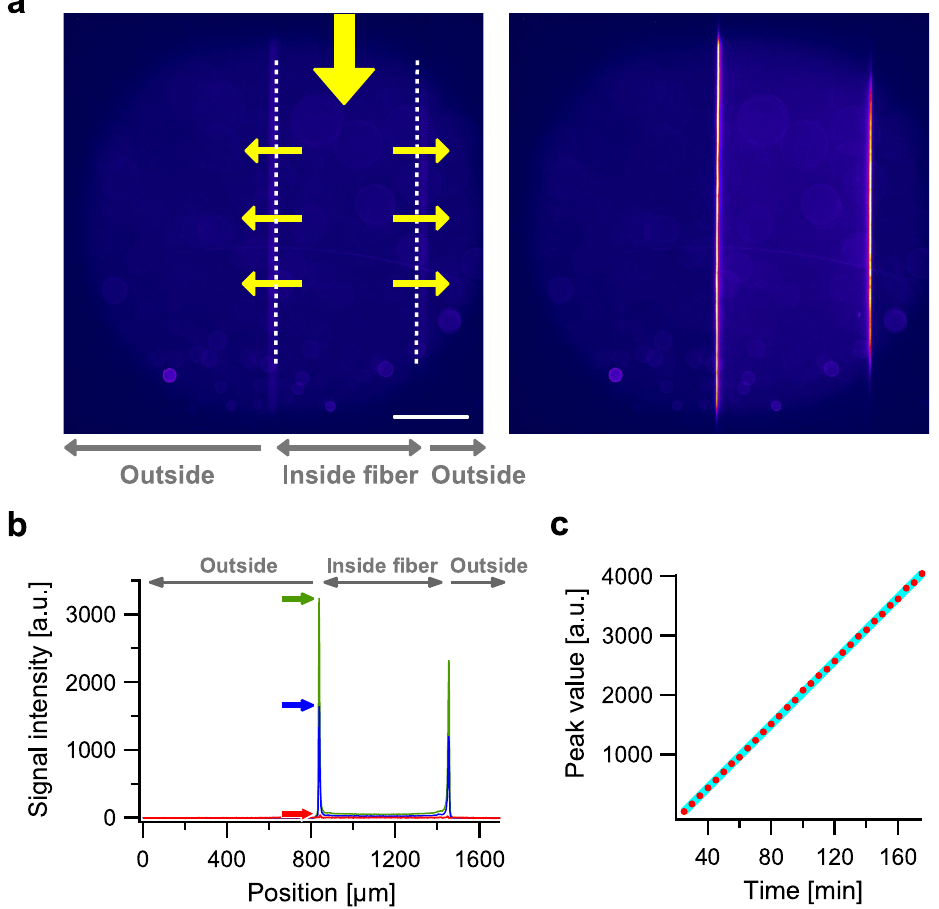
Figure 2. Visualization of the accumulation of virus-like particles (VLP) in the hollow fiber membrane using the continuum injection method. ( a ) Pseudo-color representation of fluorescent images taken by the confocal microscope. Scale bar, 300 µm. Left, whole view of a single hollow fiber membrane. White dotted lines indicate the positions of left and right edges of the lumen in the hollow fiber. Yellow arrows show the generalized movement of the solution, which was infused from the top in this figure, and then flowed sideways through the membrane. Right, image at 175 min after the VLP reached the observation area. ( b ) Signal intensity profile along the axis perpendicular to the hollow fiber. Red, blue and green lines are profiles recorded at 0, 60 and 120 min, respectively. Arrows indicate peak intensities. ( c ) Time course of the retention of the VLP trapped in the membrane as left peak values of profiles (arrows in b ). Cyan line shows a linear